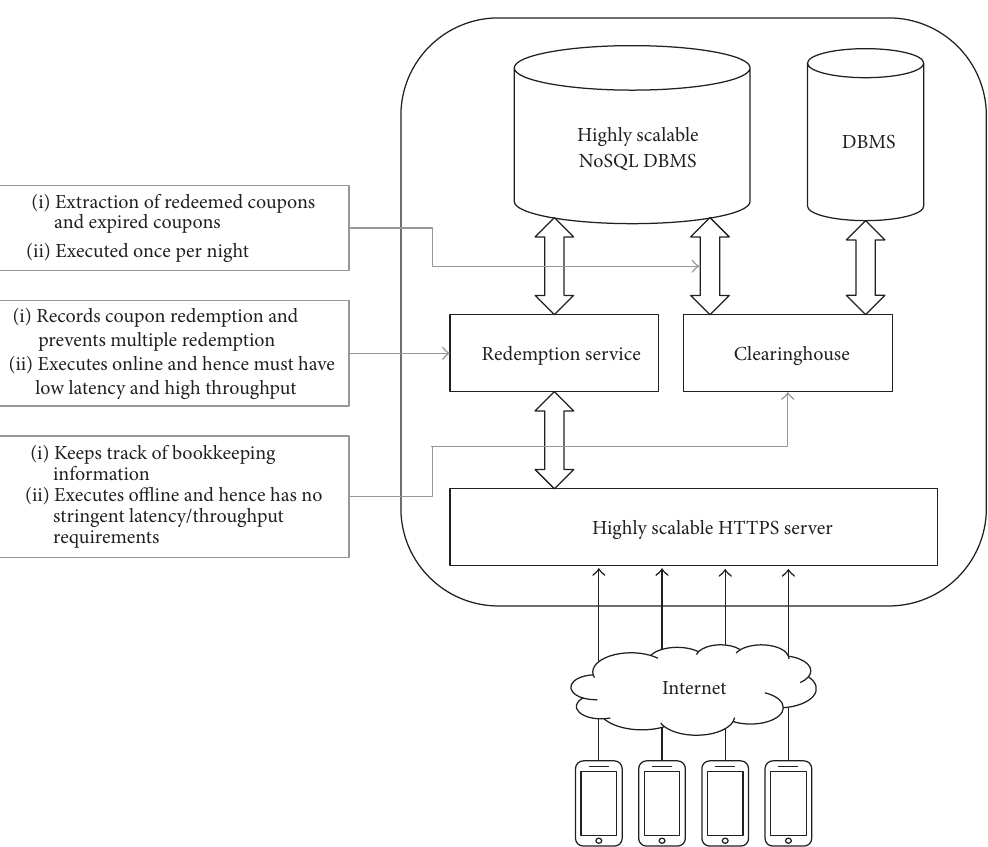
Figure 1: Centralized service